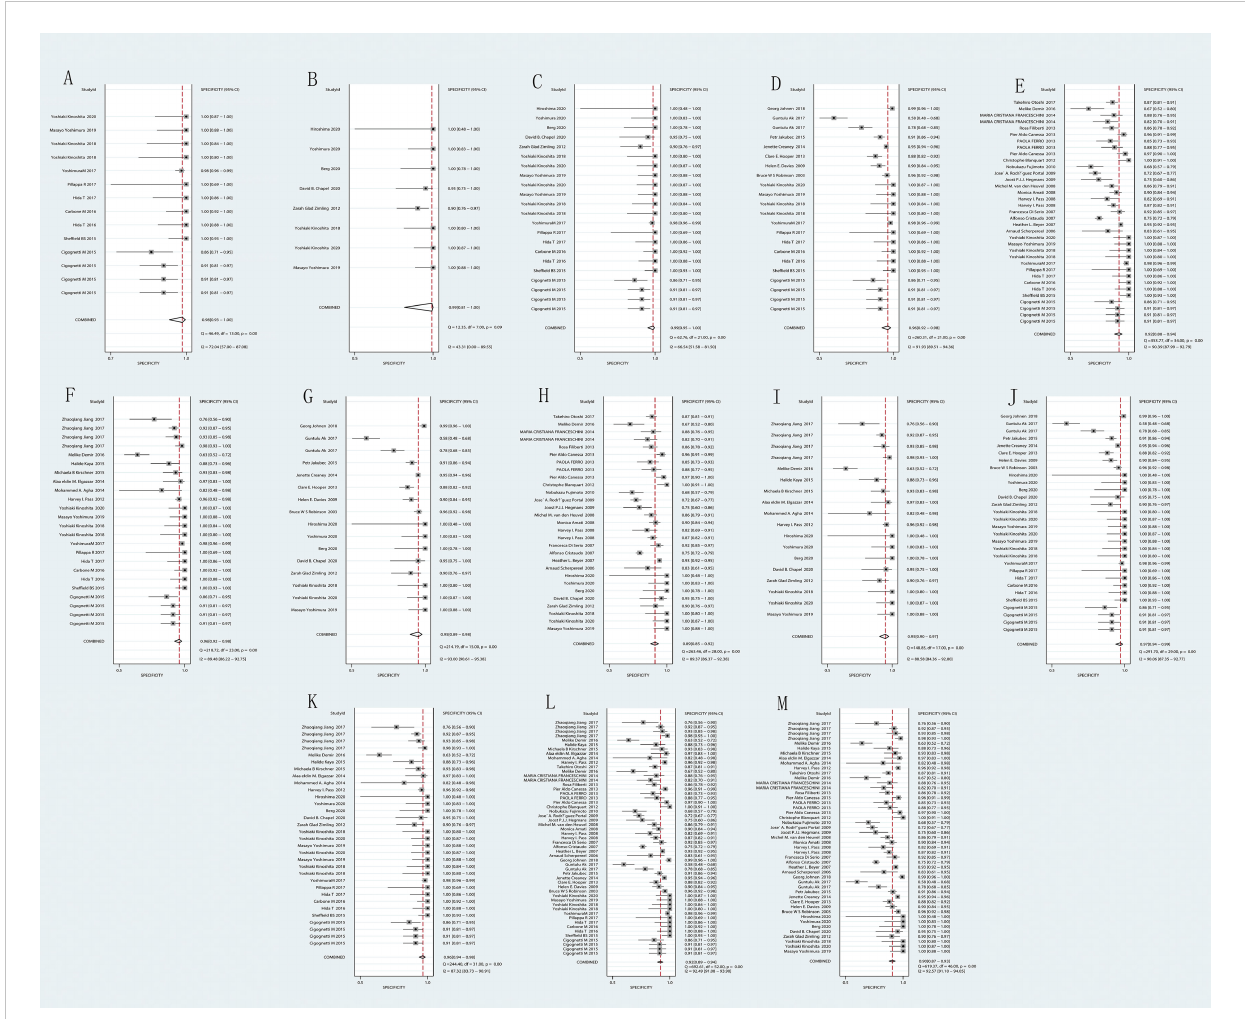
FIGURE 3 Forest plot for the pooled speci fi city (SPE) of biomarkers. (A) BAP1; (B) MTAP; (C) BAP1+MTAP. (D) BAP1+MSLN; (E) BAP1+SMRP; (F) BAP1+ Fibulin-3; (G) MTAP+ MSLN; (H) MTAP+ SMRP; (I) MTAP+ Fibulin-3; (J) BAP1+MTAP+MSLN; (K) BAP1+MTAP+ Fibulin-3. (L) BAP1+MSLN+SMRP+Fibulin-3; (M)